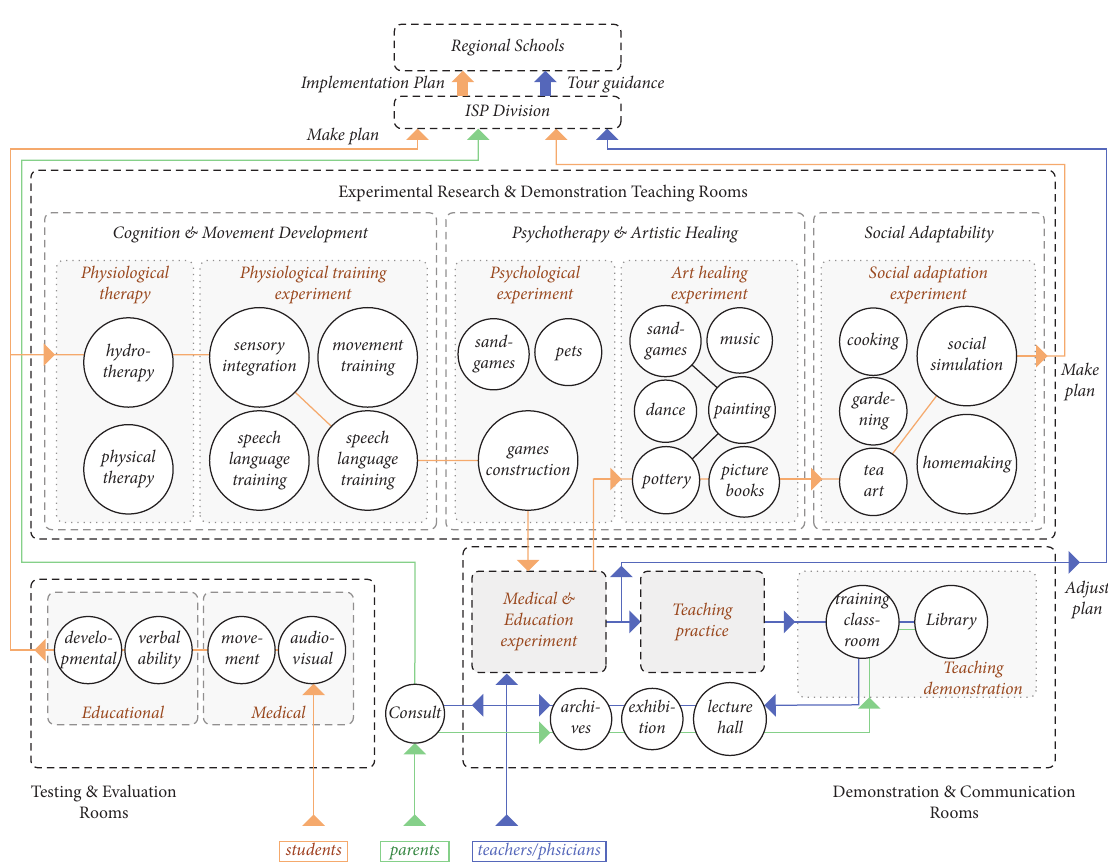
Figure 9: Functional partition of the guidance